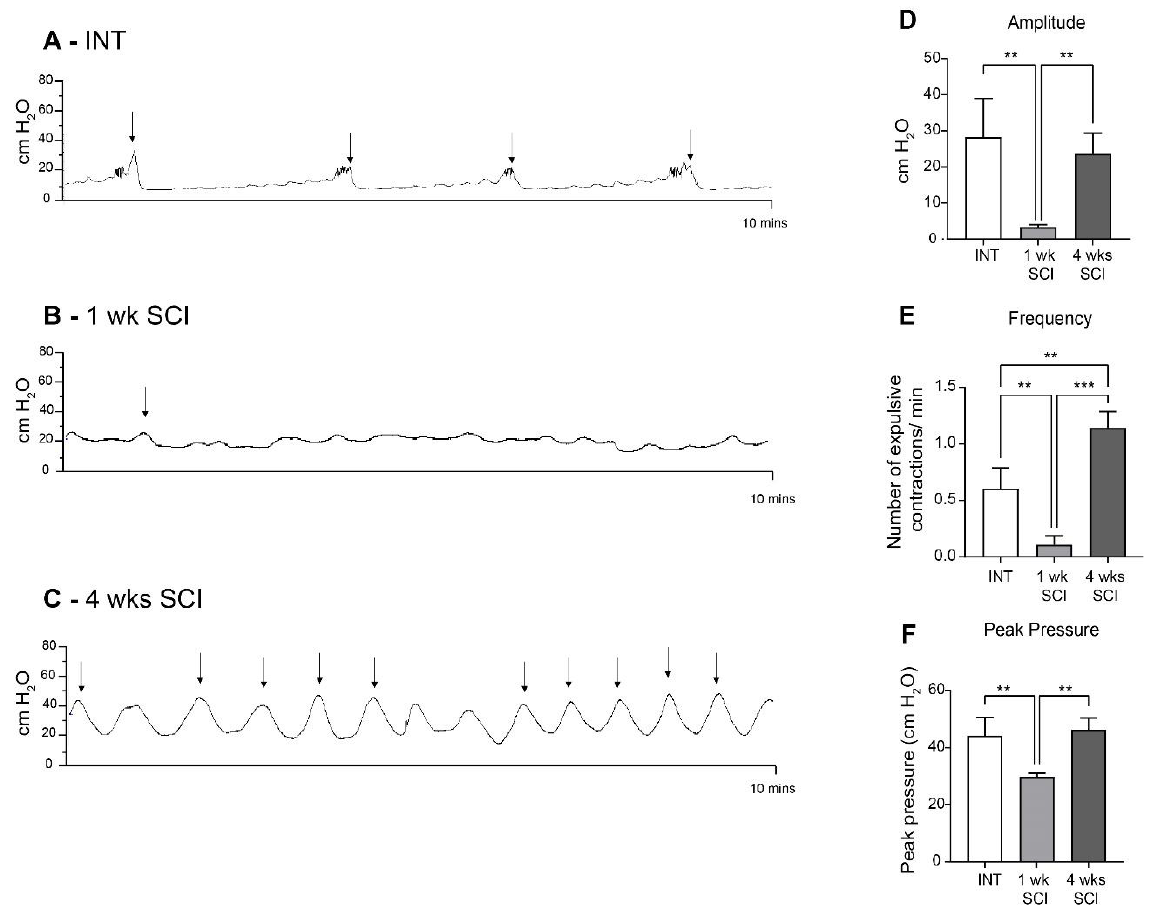
Figure 1. Bladder reflex activity. Bladder contractility was assessed by cystometry under urethane anesthesia. Intact animals ( A ) presented a typical bladder function. One week post-SCI ( B ), SCI animals were considered to be in spinal shock, with an almost total absence of bladder contractions. In 4-week SCI rats ( C ), bladder contractions were partially restored, with a pattern of bladder hyperreflexia. Urodynamic parameters, including the amplitude ( D ), frequency ( E ), and peak pressure ( F ) of the expulsion bladder contractions of the overall experimental groups ( n = 4). One-way ANOVA followed by Tukey’s multiple comparison test (** p < 0.01; *** p < 0.001;). The arrows indicate the expulsion of a drop of urine. Table 1. Urodynamic parameters from intact and SCI rats. Cystometric values of frequency, peak pressure, and amplitude of voiding contractions of spinal intact and SCI animals (1 and 4 weeks post-SCI). Cystometrograms were analyzed using the LabScribe software. Only contractions that reached at least 10 cm H 2 O of amplitude were considered for quantification. Data are represented as the mean ± standard deviation (one-way ANOVA followed by Turkey’s multiple comparison test; ** p < 0.01 compared to intact; #### p < 0.0001, ## p < 0.01 compared to 1w SCI). Spinal Intact SCI—1 Week SCI—4 Weeks Frequency 0.60 ± 0.18 Peak pressure #### p <